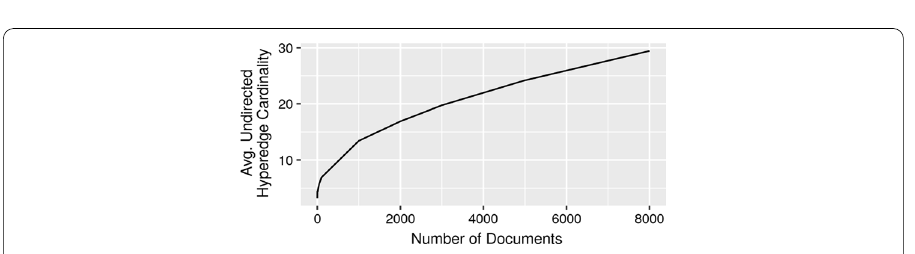
Fig. 19 Average hyperedge cardinality over time for the context model